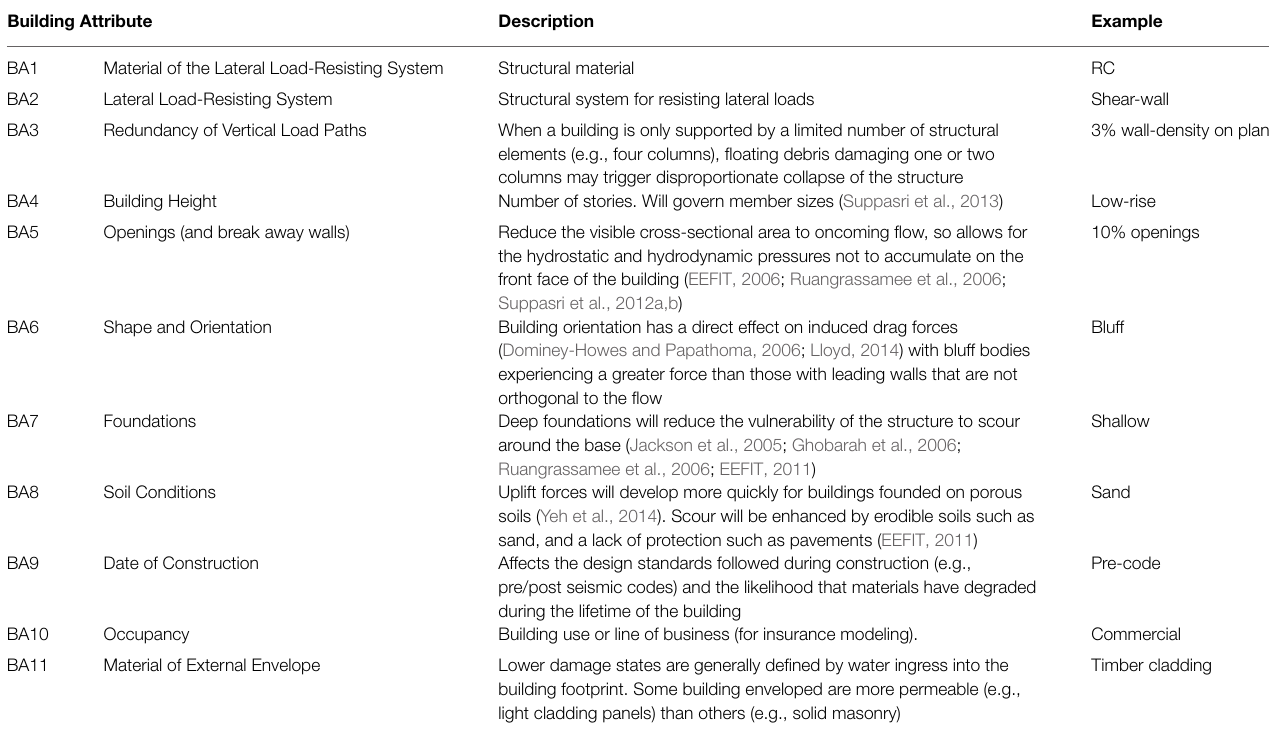
TABLE 13 | Building attributes which govern tsunami performance